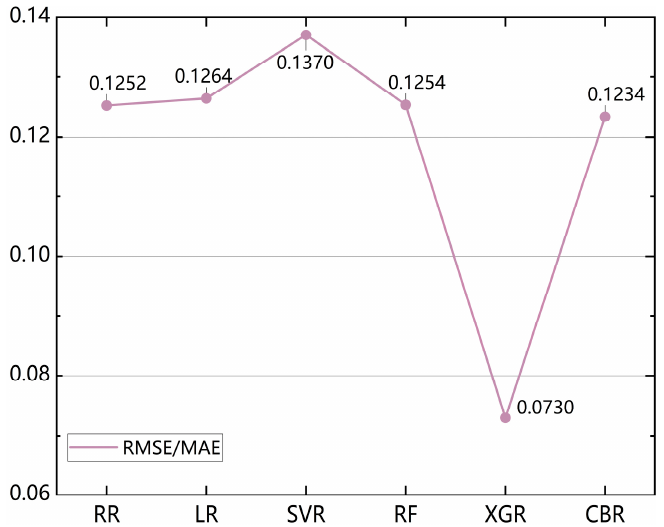
Figure 10. RMSE/MAE scores when six regression models were trained using the leave ‐ one method.